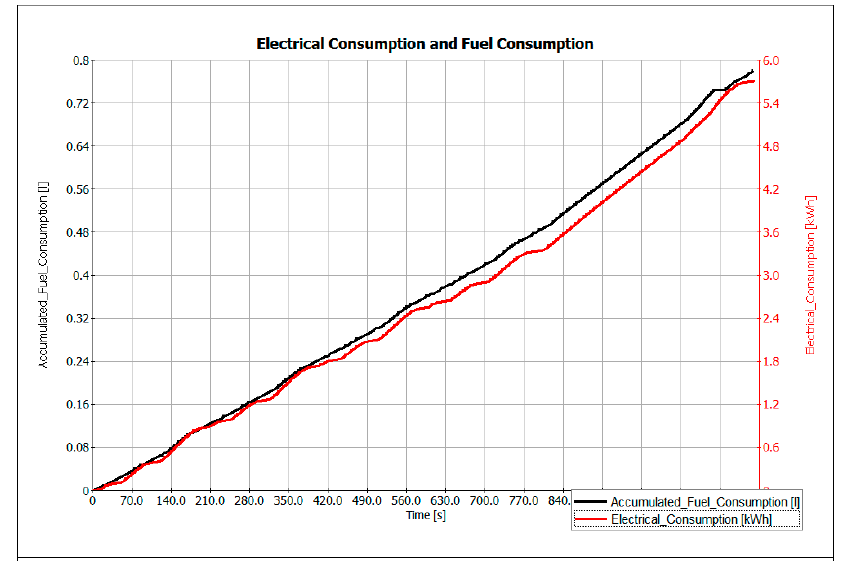
Figure 7. The fuel and power consumption curves under NEDC tests.